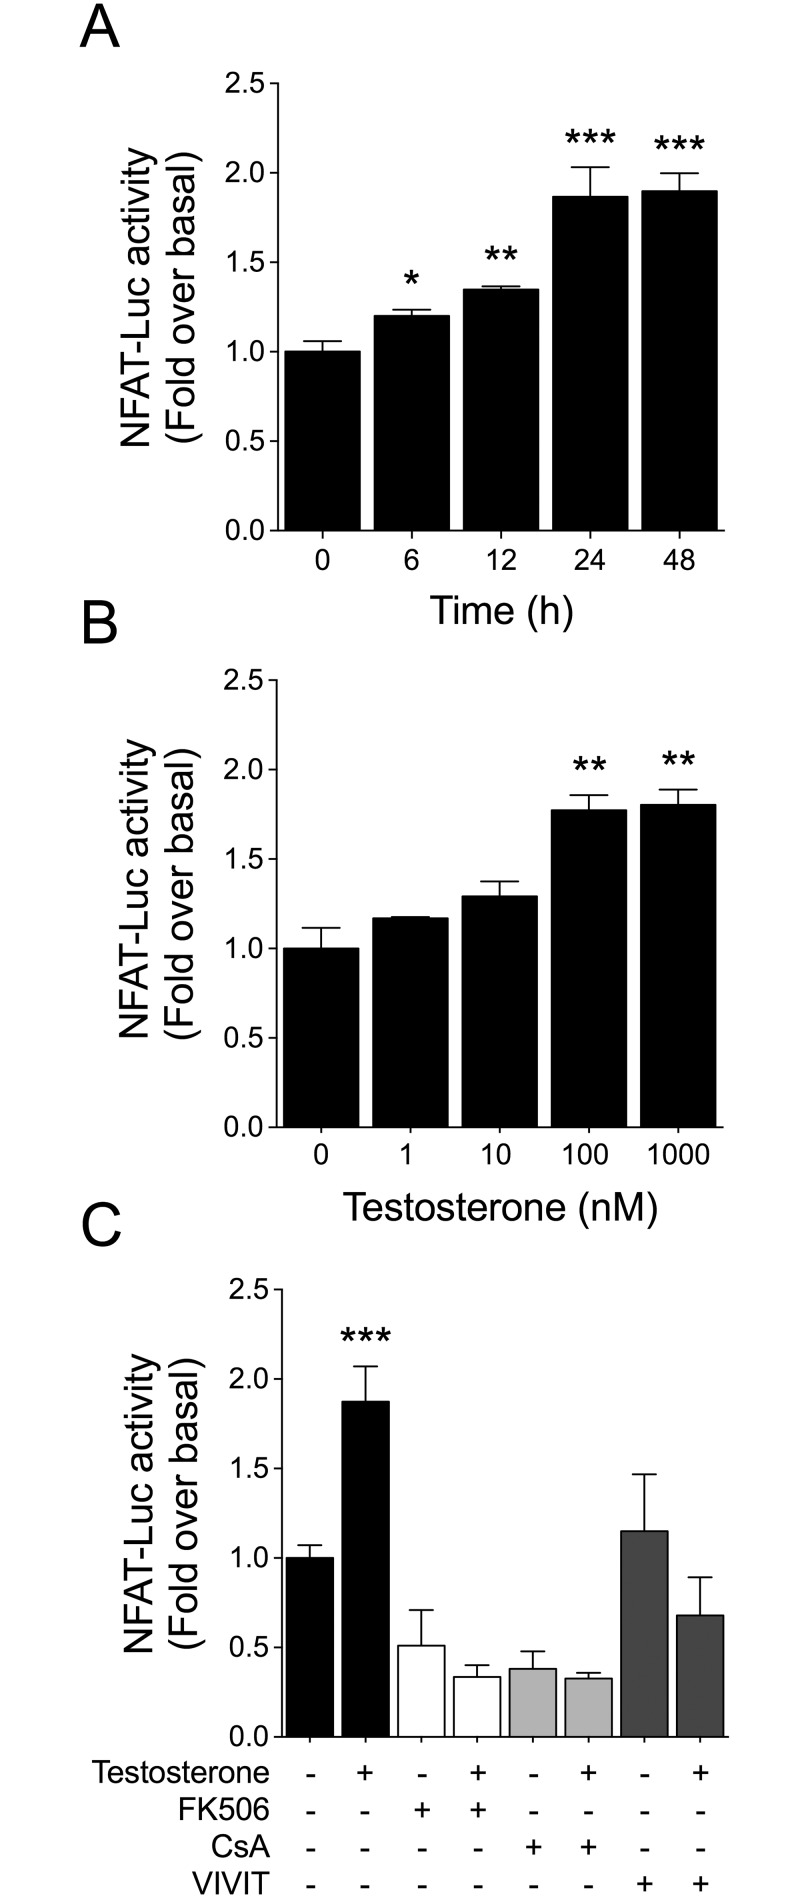
Testosterone activates NFAT in cardiac myocytes.NFAT activity was determined in cardiac myocytes transfected with a NFAT luciferase-reporter plasmid (NFAT-Luc) and normalized relative to Renilla luciferase activity in each sample. NFAT-Luc activity is expressed as fold induction relative to non-stimulated cells. (A) Cardiac myocytes were stimulated with 100 nM testosterone for 6, 12, 24, and 48 h. (B) Concentration-dependent effect of testosterone on NFAT-Luc activity. Cells were stimulated with 1, 10, 100, or 1000 nM testosterone for 24 h. Treatment with 100 and 1000 nM testosterone significantly increased NFAT-Luc activity as compared with non-stimulated cells. (C) Pretreatment of cardiac myocytes for 30 min with FK506 (1 μM), CsA (1 μM), or 11R-VIVIT (1 μM) prior testosterone stimulation (100 nM by 24 h) reduced NFAT-Luc activation. Values are presented as the mean ± SEM (n = 5 for each condition). *p < 0.05, **p < 0.01, and ***p < 0.001 vs. control non-stimulated condition.